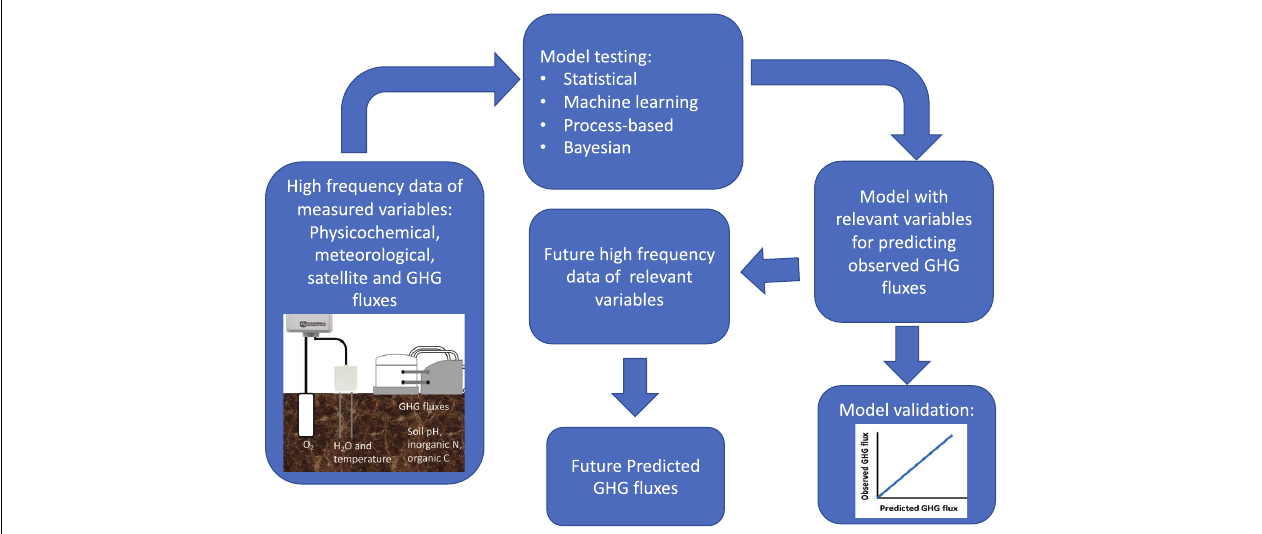
FIGURE 2 | Diagram for testing effectiveness of available models to predict GHG fluxes. High frequency data of measured variables are required to test methods and rank them according to predictive power and computational